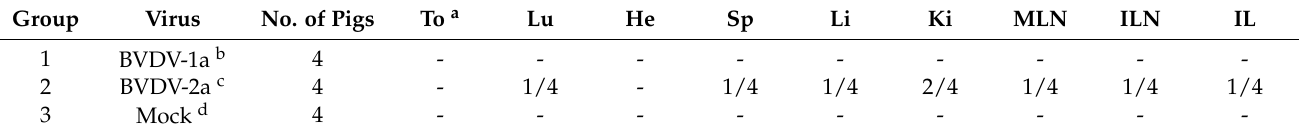
Table 2. Detection of bovine viral diarrhea virus antigens in pig organs and tissues by RT-PCR.